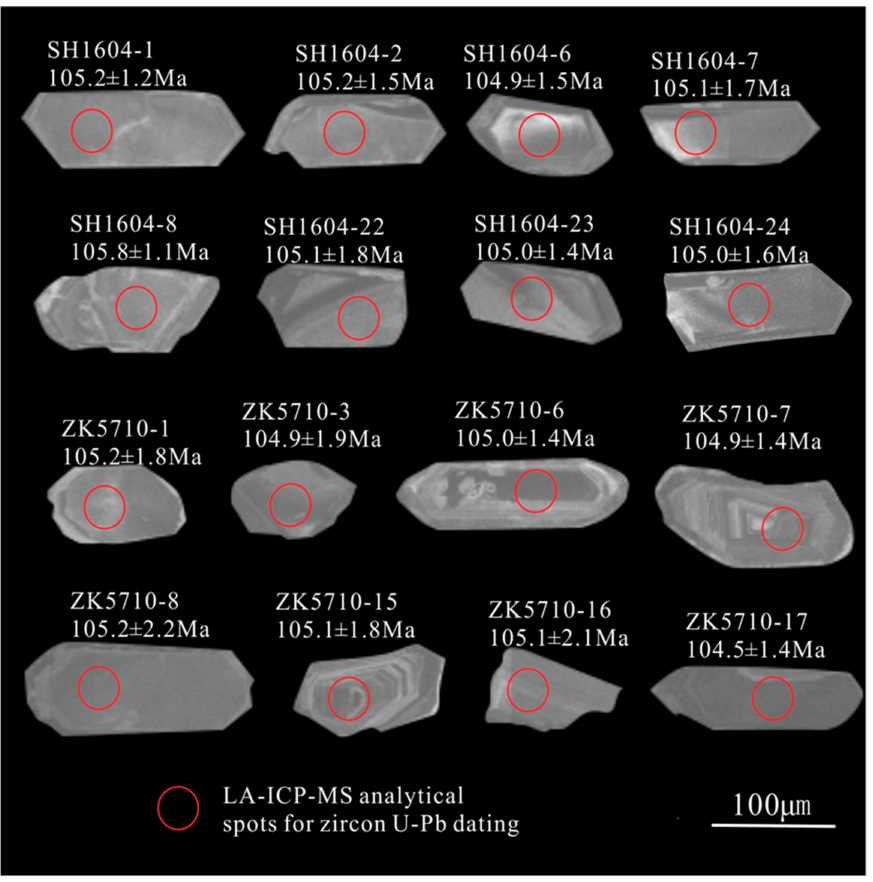
Figure 4. Representative zircon CL images showing internal textures and locations LA-ICP-MS U–Pb dating analysis spots (red circles) of volcanic rocks from the Shanghang Basin.